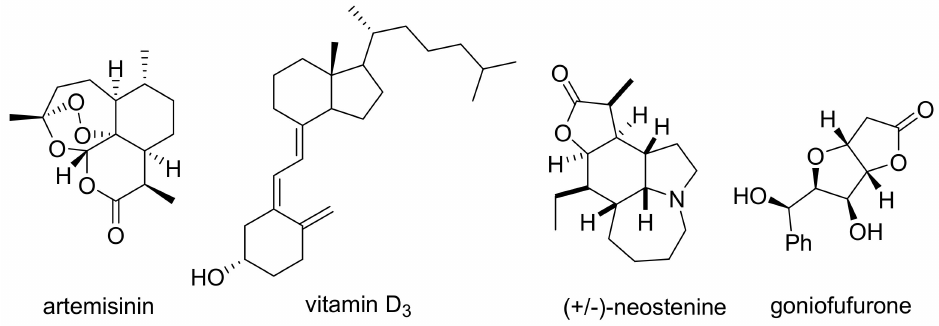
Figure 8. Structures of complex bioactive molecules featuring flow photochemistry key steps.